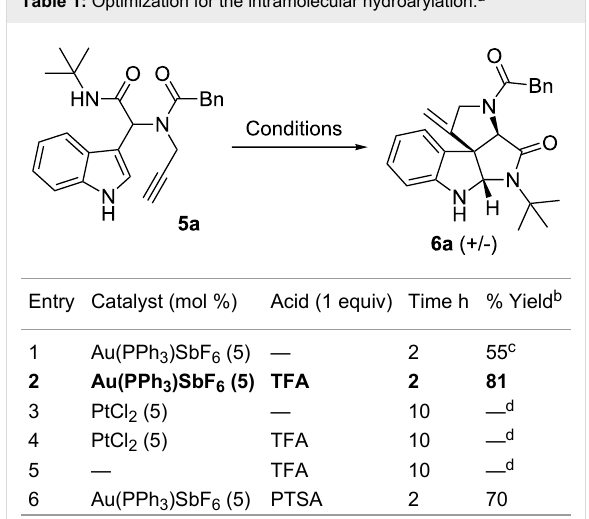
Table 1: Optimization for the intramolecular hydroarylation.